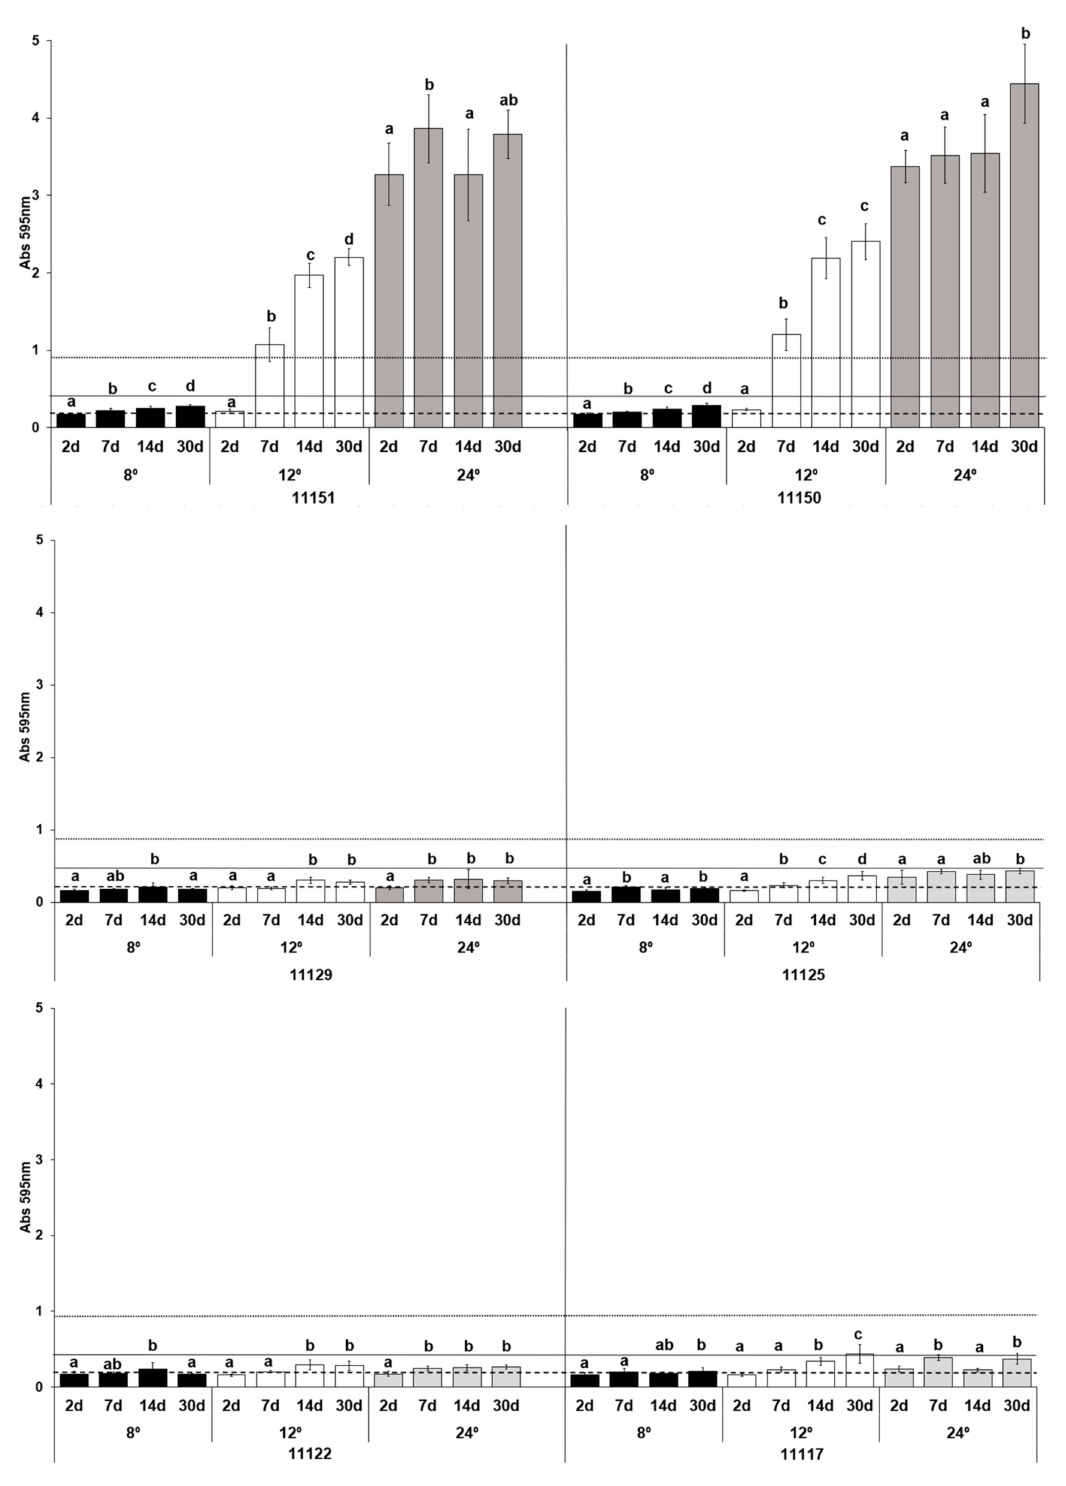
Figure 4. Biofilm-producing capacity on polystyrene of the histamine-producing L. parabuchneri strains incubated at 8, 12 and 24 ◦ C. The strains were incubated for 2, 7, 14 and 30 days. Data represent means ± SD (error bars) of three experiments. Values marked with the same letter do not differ significantly ( p > 0.05 according to the Bonferroni post-hoc test). The producer/nonproducer cut-off (weak producer) is signaled by the dashed line (ODc), the solid line is 2 × ODc (moderate producer) and the dotted line 4 × ODc (strong